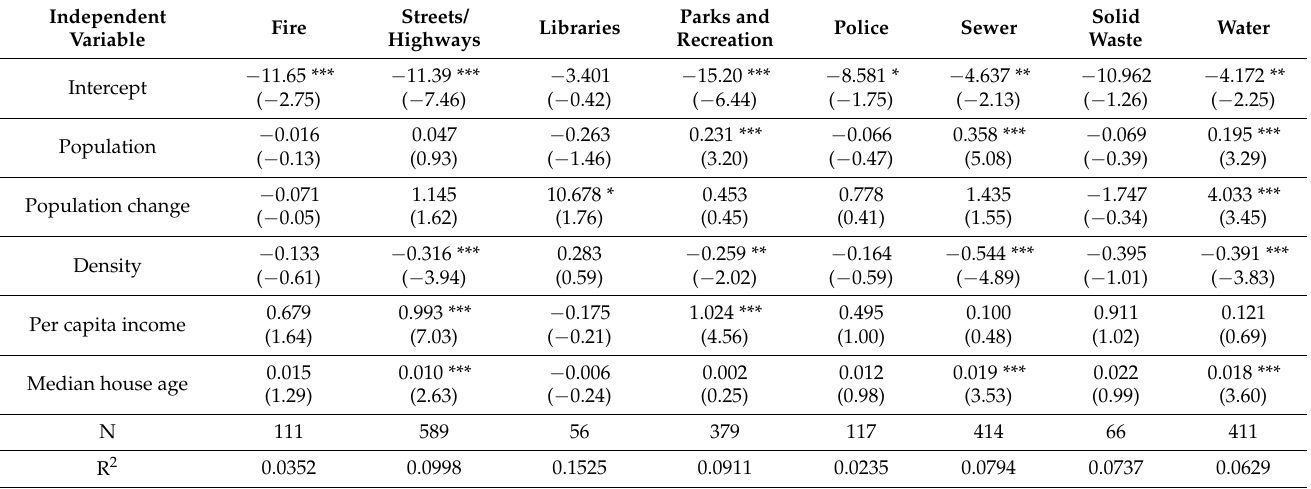
Table 4. Results for models of per capita municipal expenditures, construction